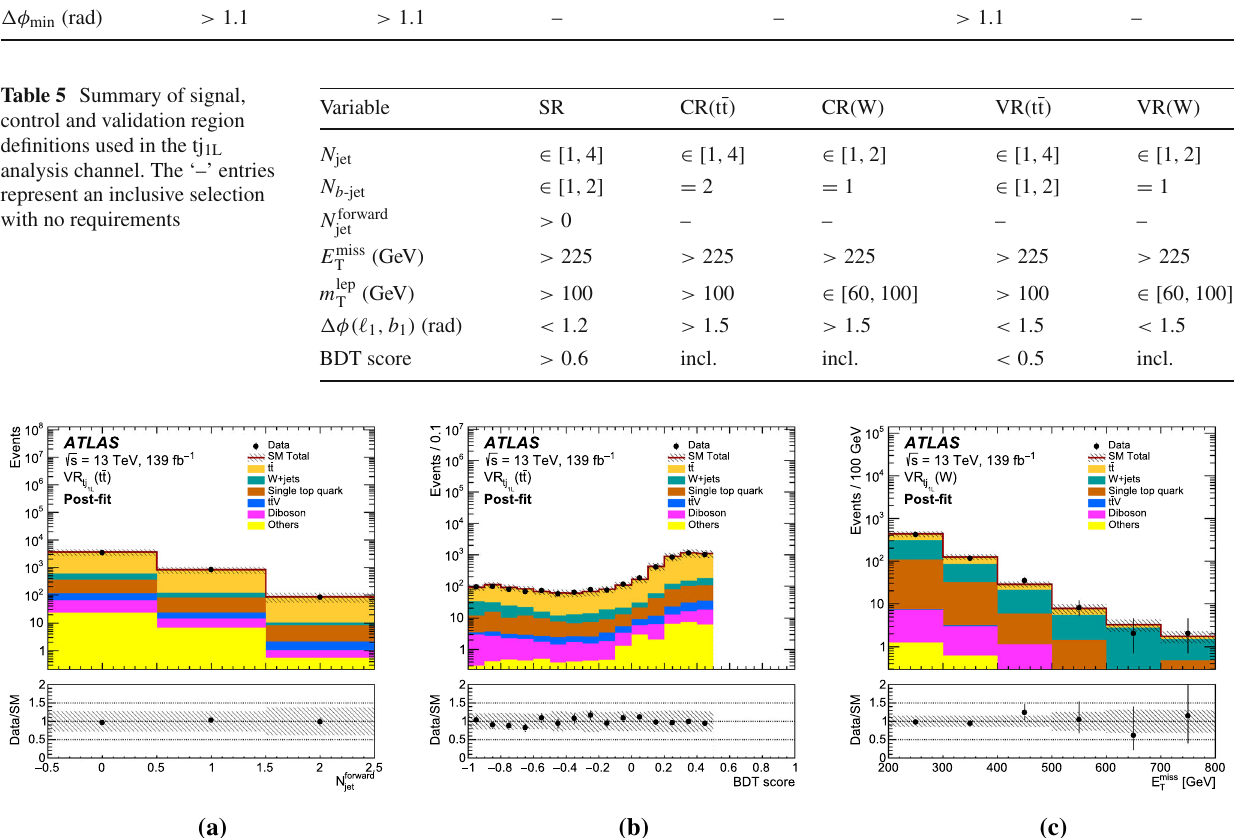
Fig. 6 Distributions in the t ¯ t and W + jets validation regions in the tj 1L analysischannel: a N forward